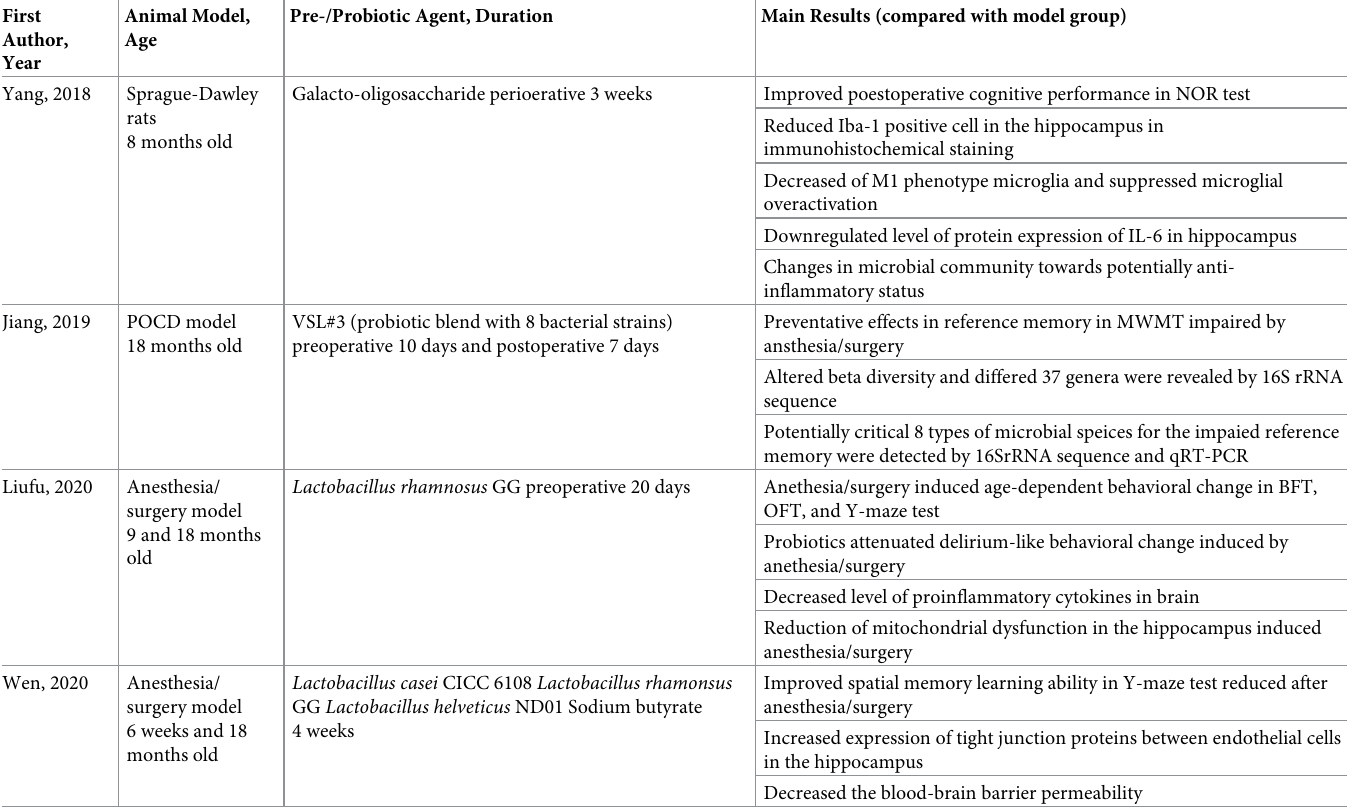
Table 1. Summary of perioperative interventional studies with pre- or probiotics in